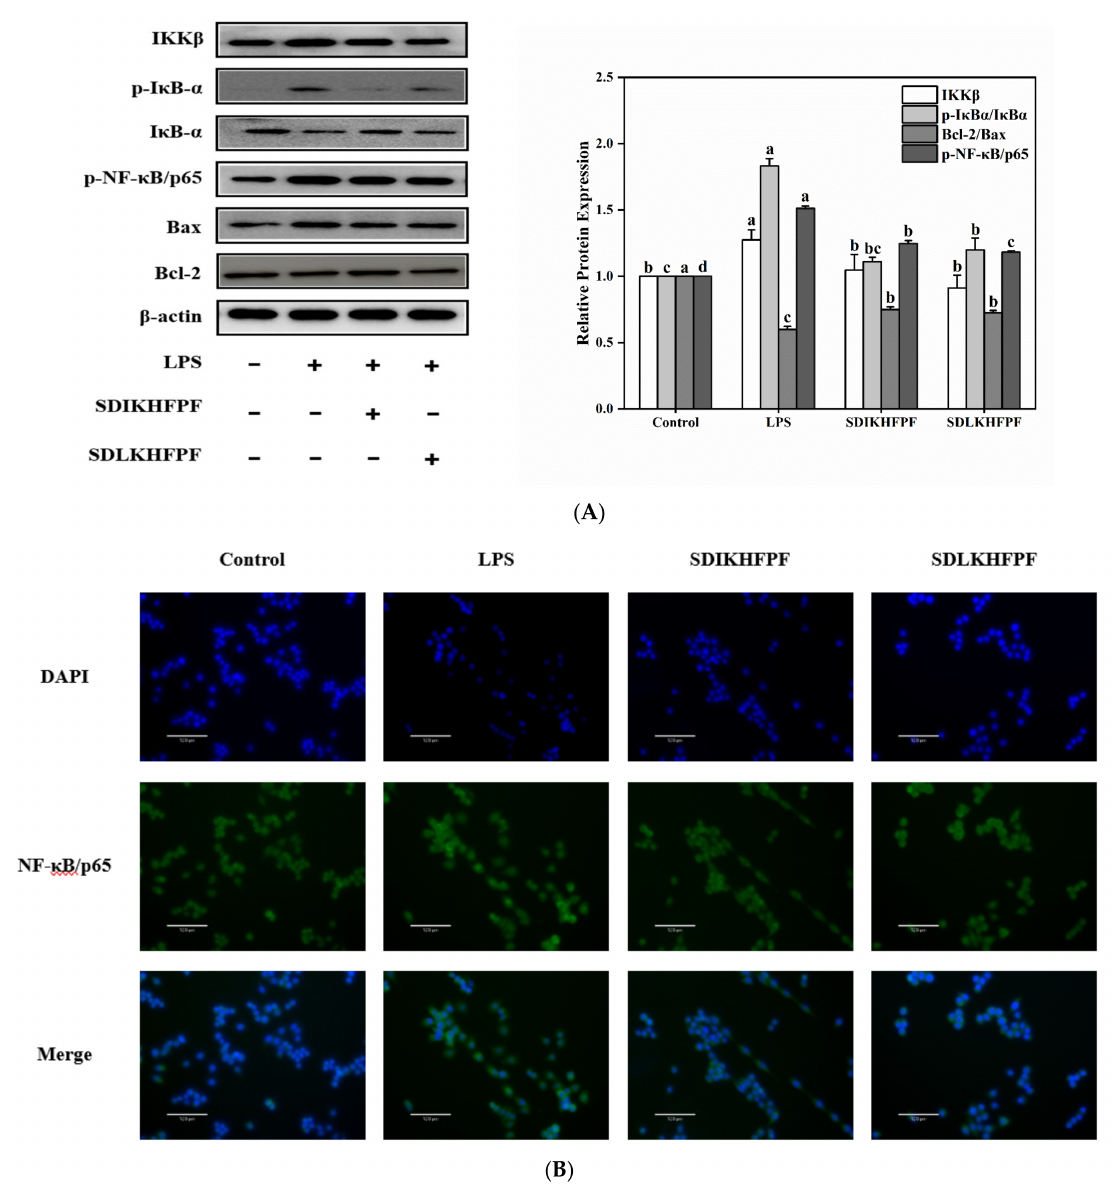
Figure 6. ( A ) The Western blot analysis of IKK β , p-I κ B α , Bcl-2/Bax, and p-NF- κ B/p65 in RAW264.7 macrophages. β -actin was used as a loading control. ( B ) The localization of p65 in the cytoplasm and nucleus was measured by immunofluorescence staining. Blue fluorescence represents cell nucleus and green fluorescence represents p65. All of the data shown were the mean ± SD ( n = 3). Different letters mean statistically significant differences at the level of p <